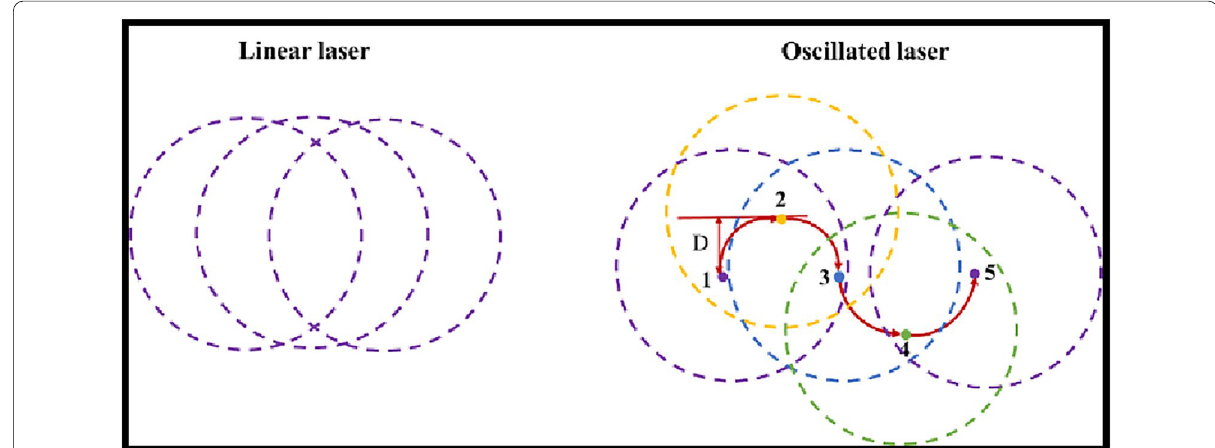
Figure 5 Schema of the laser beam oscillation during a circular movement